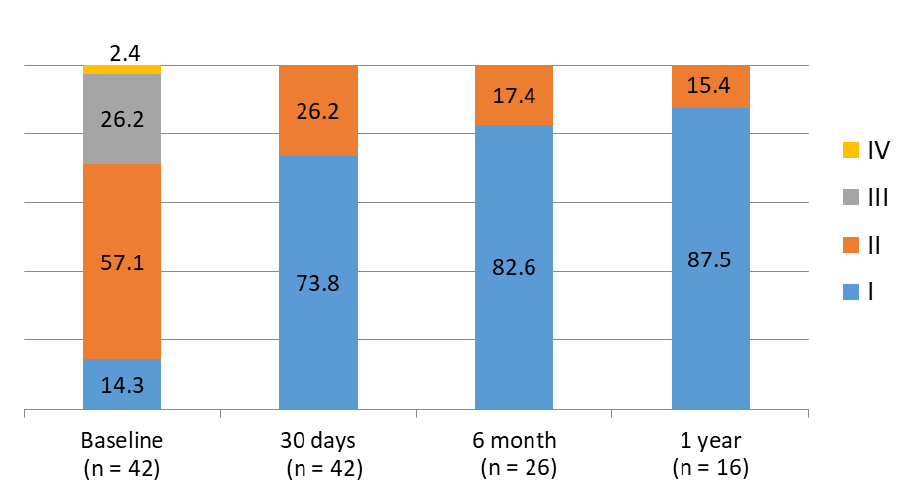
Figure 4. RV (right ventricle) ejection fraction (%) over time, as seen with cardiac MRI (magnetic resonance image). Values are presented as the mean ± standard deviation (range).